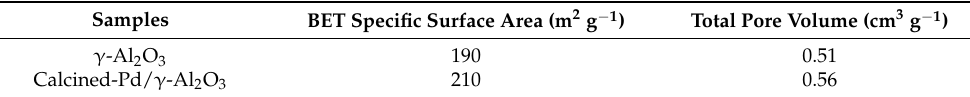
Table 1. Textural properties of γ -Al 2 O 3 and calcined PdAl 2 O 3 from N 2 physisorption.